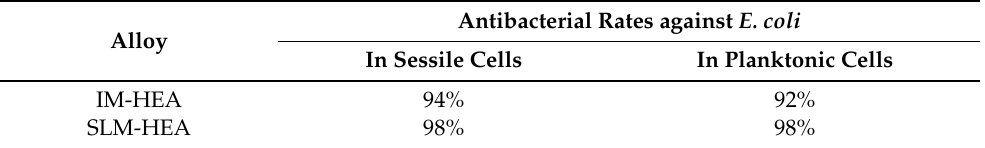
Table 9. Comparison of antibacterial rates against E. coli by fused CoCrFeCuNi and by SLM. Antibacterial Rates against E. coli Alloy In Sessile Cells In Planktonic Cells IM-HEA 94% 92% SLM-HEA 98%